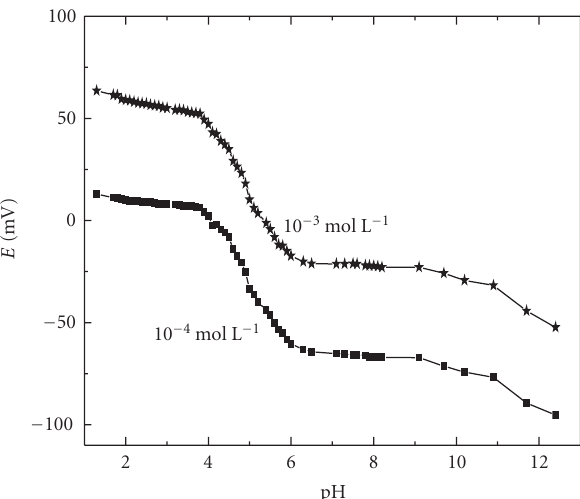
Figure 3: E ff ect of pH on the potentiometric response of ramipril- phosphomolibdate PVC membrane electrode.